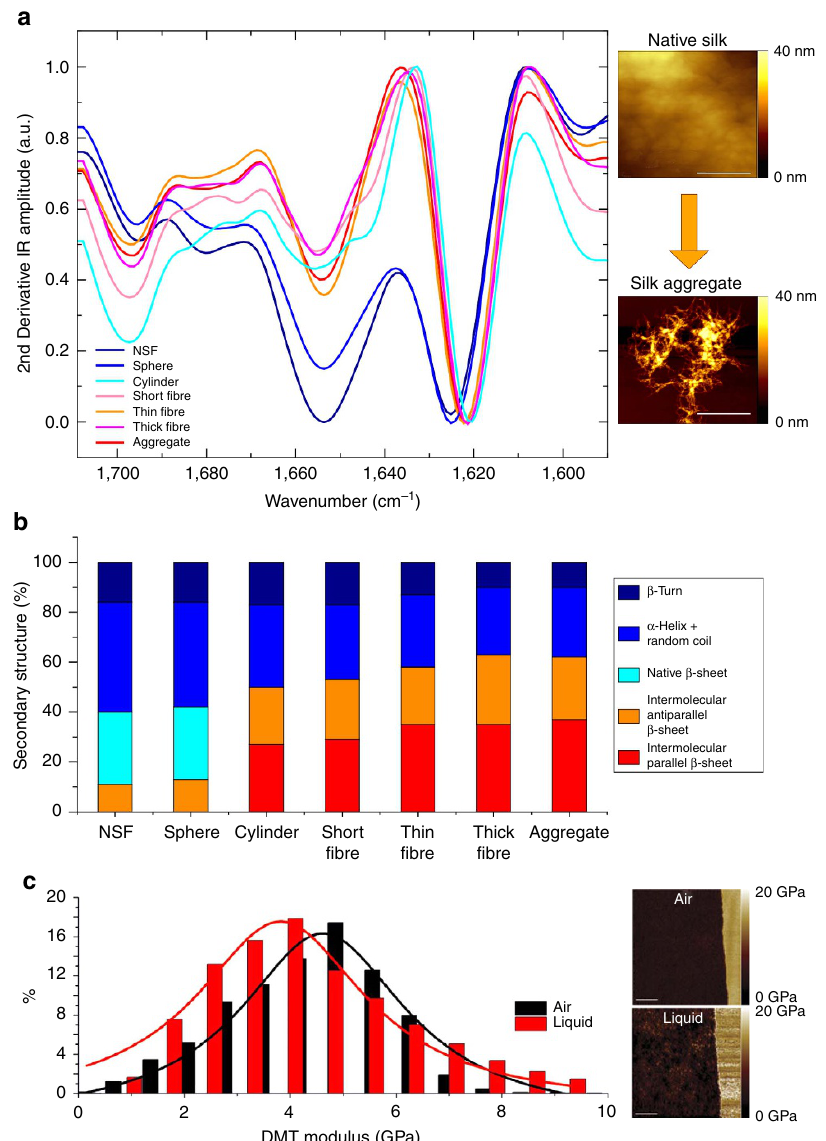
Figure 3 | Ultrastructural properties of micrococoon. ( a ) FTIR spectra of spheres, cylinders and of, short, thin and thick fibres. AFM images of native and aggregated NSF are shown at the right hand side of the FTIR spectra with scale bars of 400nm. ( b ) Chart summarizing the structural changes of NSF upon its conversion into its different forms, calculated from the amide I bands in the FTIR spectra (Supplementary Fig. 3a). ( c ) AFM DMT modulus (Derjaguin-Muller-Toporov model of elastic contact) images in air and in liquid (right) with the corresponding distribution of the DMT modulus (left). Scale bar,